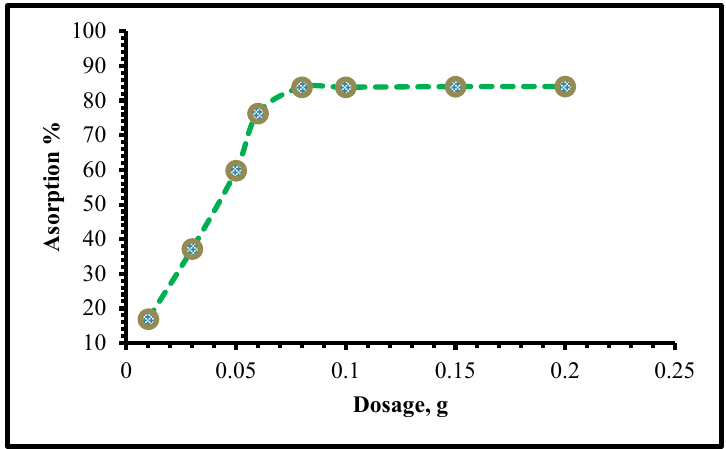
Figure 6. Influence of adsorbent dosage upon the adsorption capability of Cr(VI) on TIHP (time 30 min., 20 mL sample, pH 2, [Cr(VI)] = 250 mg/L, and T = 25 ± 1 °C).